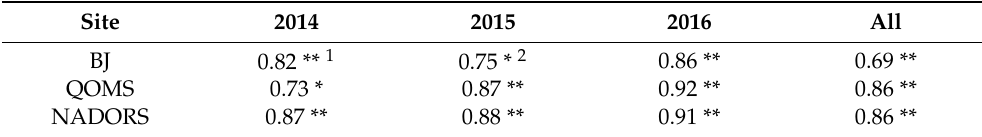
Figure 10. The ( a ) soil temperature (Ts, °C) at the depths of 0.0 m and 0.20 m, and soil apparent thermal diffusivity (k, m 2 s − 1 ), and ( b ) soil moisture ( θ , m 3 m − 3 ) at the depths of 0.0 m, 0.10 m and 0.20 m over DOYs 0–70, 2016, at NADORS. The labels of k are marked in cyan when the soil amplitude at the 0.2 m depth is less than 0.1 °C. Table 4. Correlation coefficient (r) of the monthly soil moisture and NDVI for 2014-2016 at the three